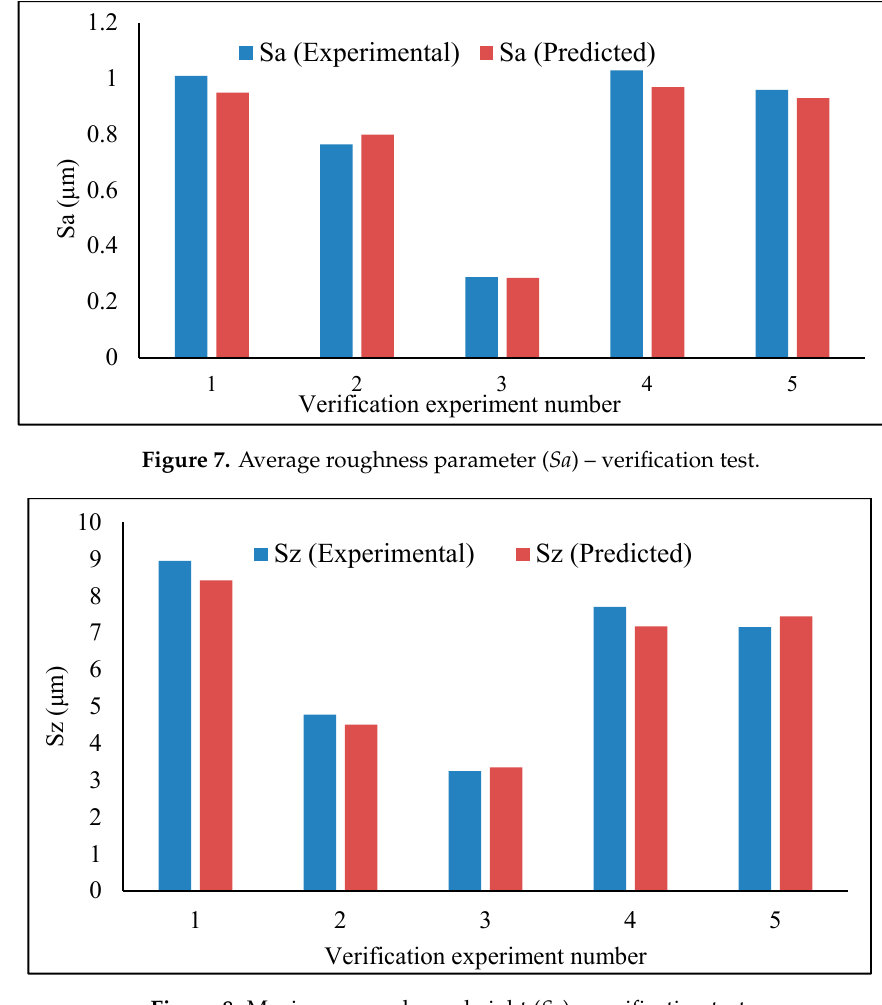
Figure 8. Maximum roughness height ( Sz ) – verification test.